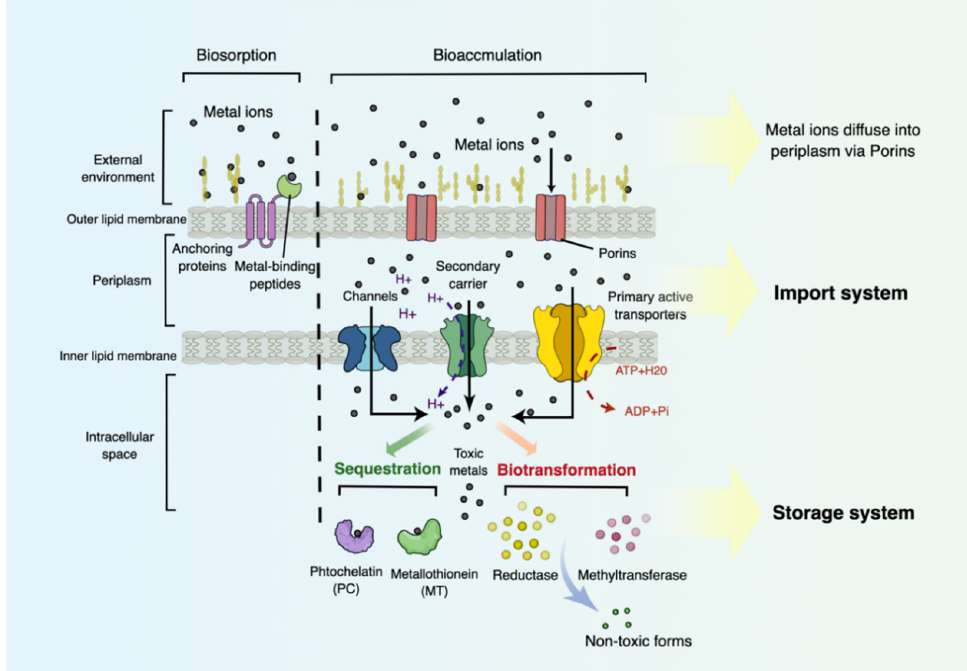
Figure 3. Import system and storage system adapted in Gram-negative bacteria towards bioaccu- mulation. Biosorption is indicated in the left side. The import system used in bioaccumulation includes primary active transporters (requiring NTPs such as ATP), secondary carriers (requiring a proton concentration gradient), and channels (no energy needed), by which metal ions are imported across the inner lipid membrane into the cytoplasm and undergo the process of the storage system. The storage system is responsible for HM sequestration by attachment to different metal-binding proteins/peptides (represented by PCs and MTs) or HM biotransformation by various detoxifying enzymes (represented by Hg reductase and As methyltransferase). By Figdraw(www.figdraw.com accessed on 1 April 2022).